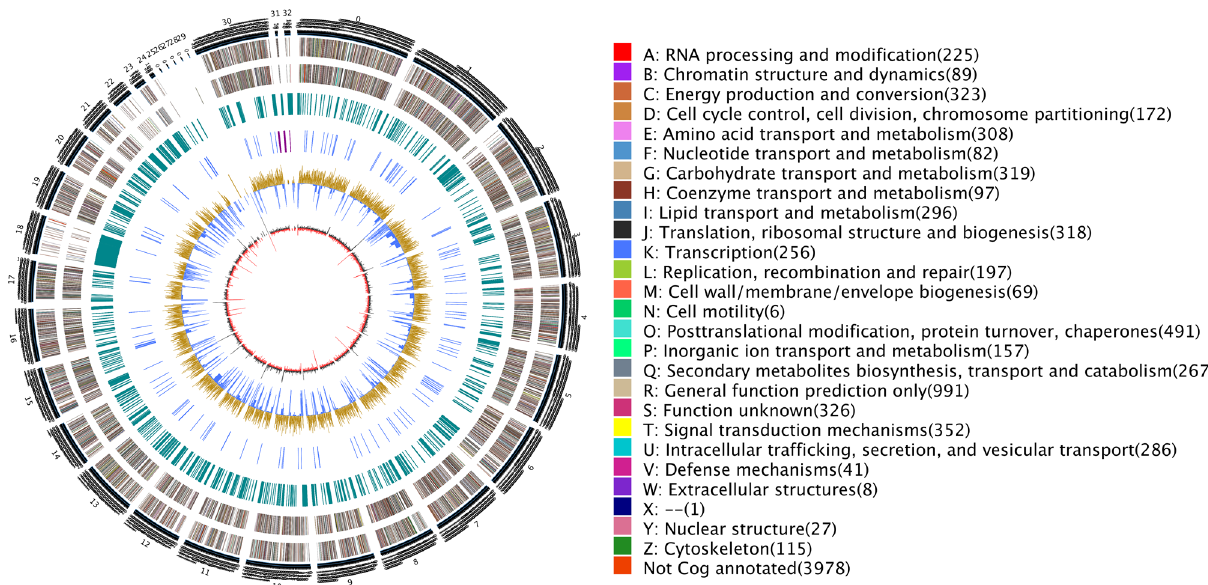
Figure 1. Genomic map of Stagonosporopsis cucurbitacearum ( Sc .). The outermost circle is a marker of genome size with each demarcation representing 5 kb that shows the entire genome size of Sc. zq-1 of 35.28 Mb. The second and third circles from the outside show positions of genes coded by plus and minus strands of the genome, respectively. The function and gene number annotated by COG are listed on the right of the figure whereby each function corresponds to a color and each color corresponds with a different COG functional classification. The fourth circle shows repeating sequences. The fifth circle shows genes coding for tRNA and rRNA, where blue and purple represent tRNA and rRNA, respectively. The sixth circle shows the GC content, the light yellow part shows GC content is higher than the mean GC content of genome, the higher the peak value is, the bigger the difference is, and the blue part shows GC content is lower than the mean GC content of genome; The innermost circle shows the GC-skew, with dark gray representing regions where G is greater than C and red representing regions where C is greater than G. Circos (https ://circo s.ca/) was used for drawing